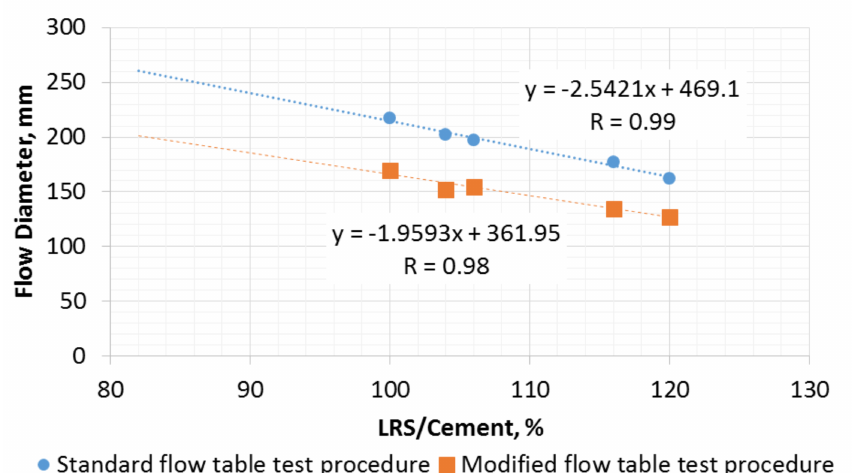
Figure 7. The consistency of lunar micro-mortars of w/c = 0.50 expressed by flow diameter (test performed acc. to the modified test procedure and standard test procedure in conformity with EN 1015-3).